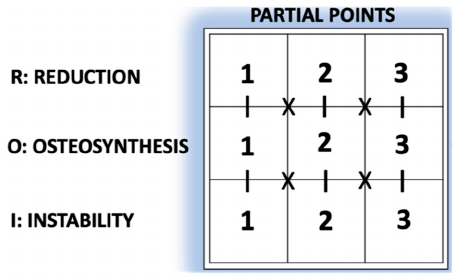
Figure 2. GammaTScore scoring system.